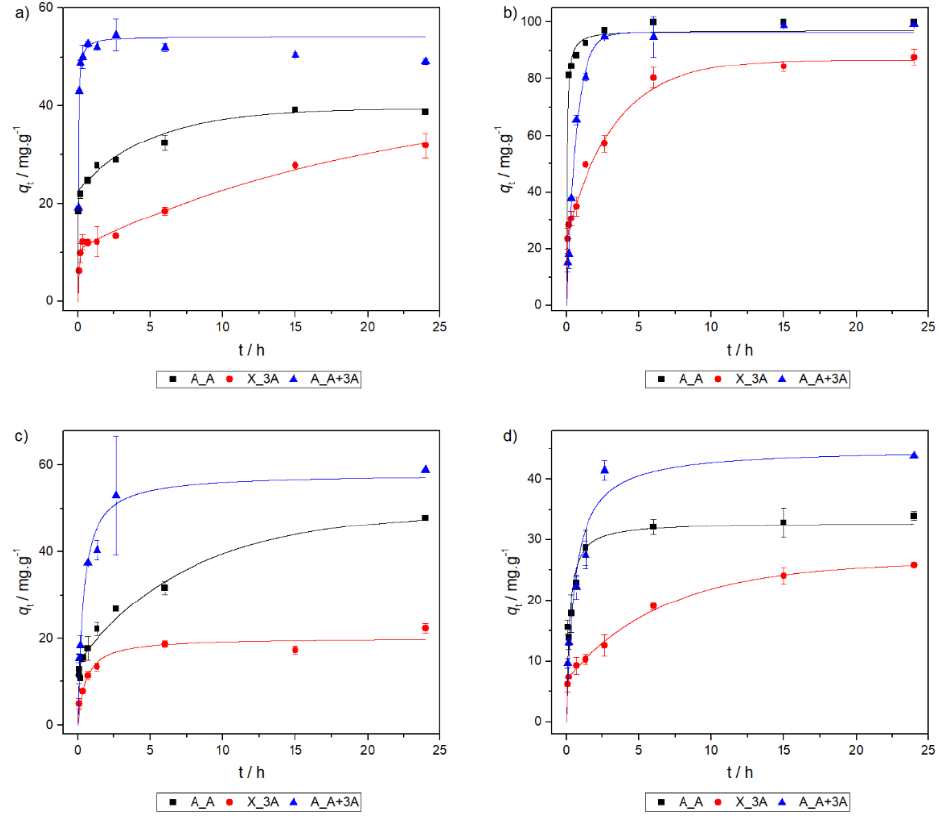
Figure 5. Sorption kinetics for ( a ) copper, ( b ) lead, ( c ) cadmium and ( d ) nickel.